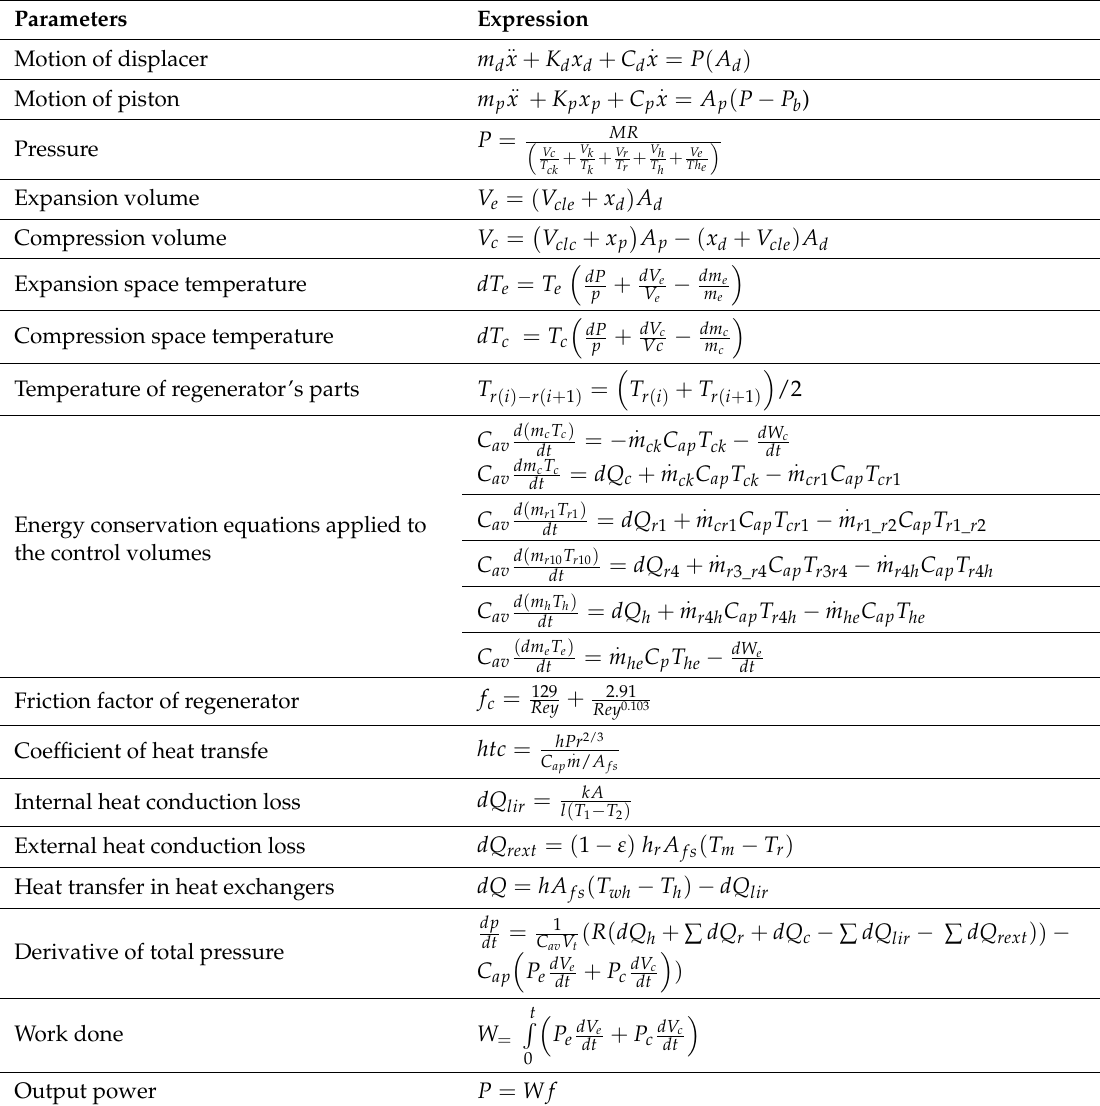
Table 1. Equations used in the mathematical